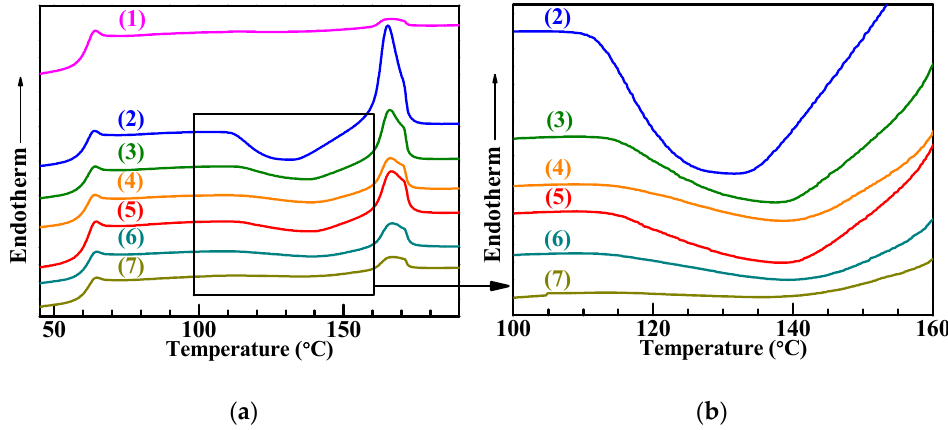
Figure 3. ( a ) Di ff erential scanning calorimetry (DSC) thermograms and ( b ) magnification of the squared Figure 3. ( a ) Differential scanning calorimetry (DSC) thermograms and ( b ) magnification of the region in (a) in the second heating cycle at a rate of 20 ◦ C / min for (1) (neat) PLA, (2) a blend of PLA and squared region in (a) in the second heating cycle at a rate of 20 °C/min for (1) (neat) PLA, (2) a blend a SBS (95 / 5 w / w), PLA / SBS (95 / 5 w / w) blend compatibilized with (3) 1.0 wt % and (4) 3.0 wt % of S-MA, (5) a blend of PLA and SBS (90 / 10 w / w), PLA / SBS (90 / 10 w / w) blend compatibilized with (6) 1.0 wt % and (7) 3.0 wt % of S-MA. Table 1. Thermal transitions, i.e., glass transition temperatures ( T g ’s), “cold”-crystallization (recrystallization) temperatures ( T cc ’s), “cold”-crystallization enthalpies ( ∆ H cc ’s), melting temperatures ( T m ’s), and melting enthalpies ( ∆ H m ’s), as well as relative degrees of (melt) crystallinity ( X c ’s), analyzed from Figure 3a DSC traces, for the (neat) PLA and the PLA / SBS (95 / 5 and 90 / 10 w / w) blends compatibilized with di ff erent concentrations (0, 1.0, and 3.0 wt %) of S-MA. Specifically, the X c values were estimated from the ∆ H m values using Equation (1).